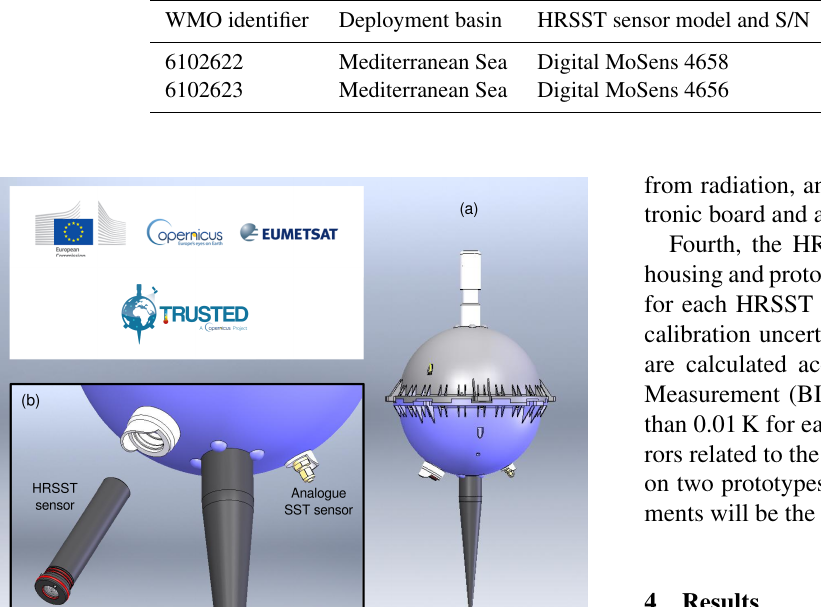
Table 4. Similar to Table 1 but for two prototype SVP-BRST buoys (each buoy is fitted with a HRSST and static pressure probe).